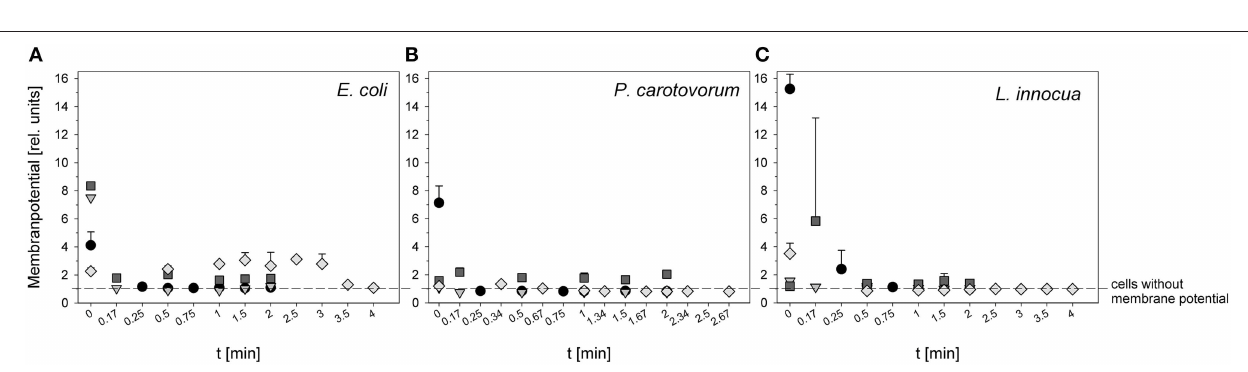
FIGURE 2 | Relative membrane potential of E. coli (A), P. carotovorum (B), and L. innocua (C) after PAA treatment (circles: 10 ◦ C, 0.25% PAA), CAPP treatment (rhombus: 20 W), and treatment with ozonated water [triangle: 3.8 ± 1.02mg l − 1 O 3 (–); square: 3.8 ± 1.02mg l − 1 O 3 ( + )] expressed as red/green ratio of DiOC 2 (3)-fluorescence